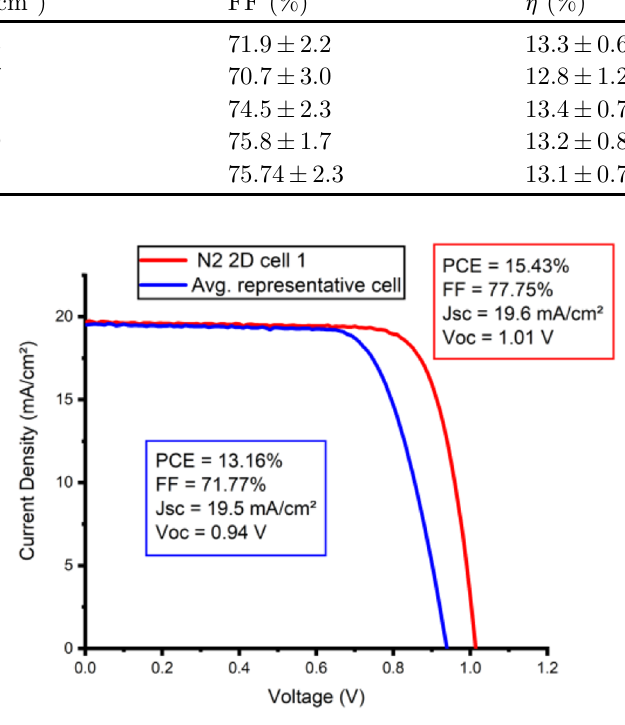
Fig. 10. J – V curve of champion and average-representative cells obtained with high pressure gas quenching and 0.5 M solution. For the average-representative cell, the one with closest performance to the average values was